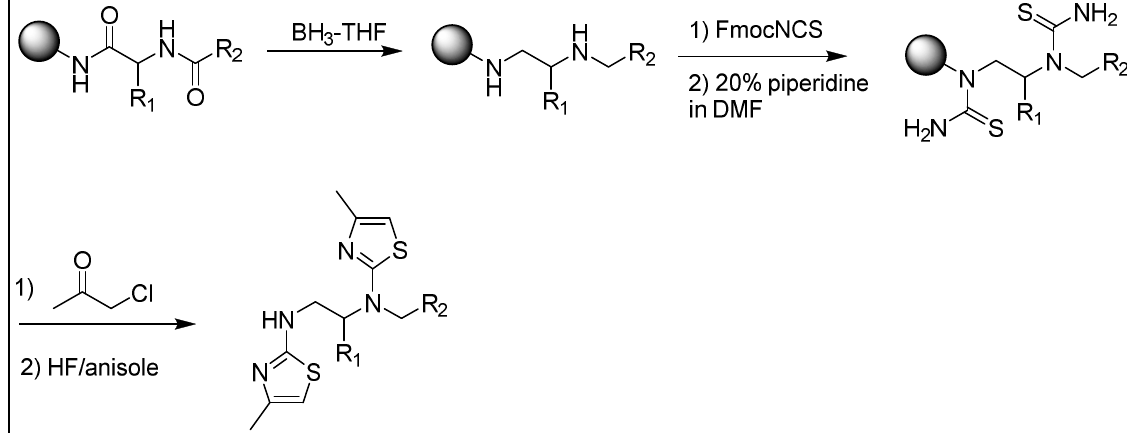
Figure 4. Synthetic strategy of library TPI-2103 and individual compounds TPI-2648.